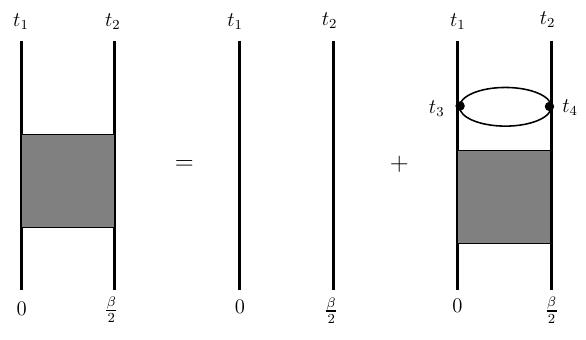
Figure 12 . Integral equation for the sum of ladder